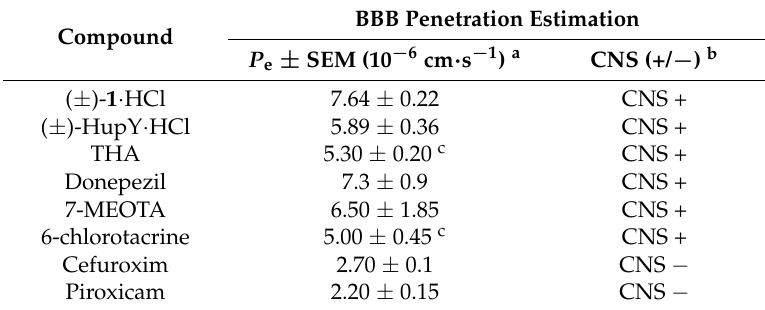
In vitro BBB permeability prediction for ( ± )- 1 · HCl and ( ± )-HupY · HCl as positive reference